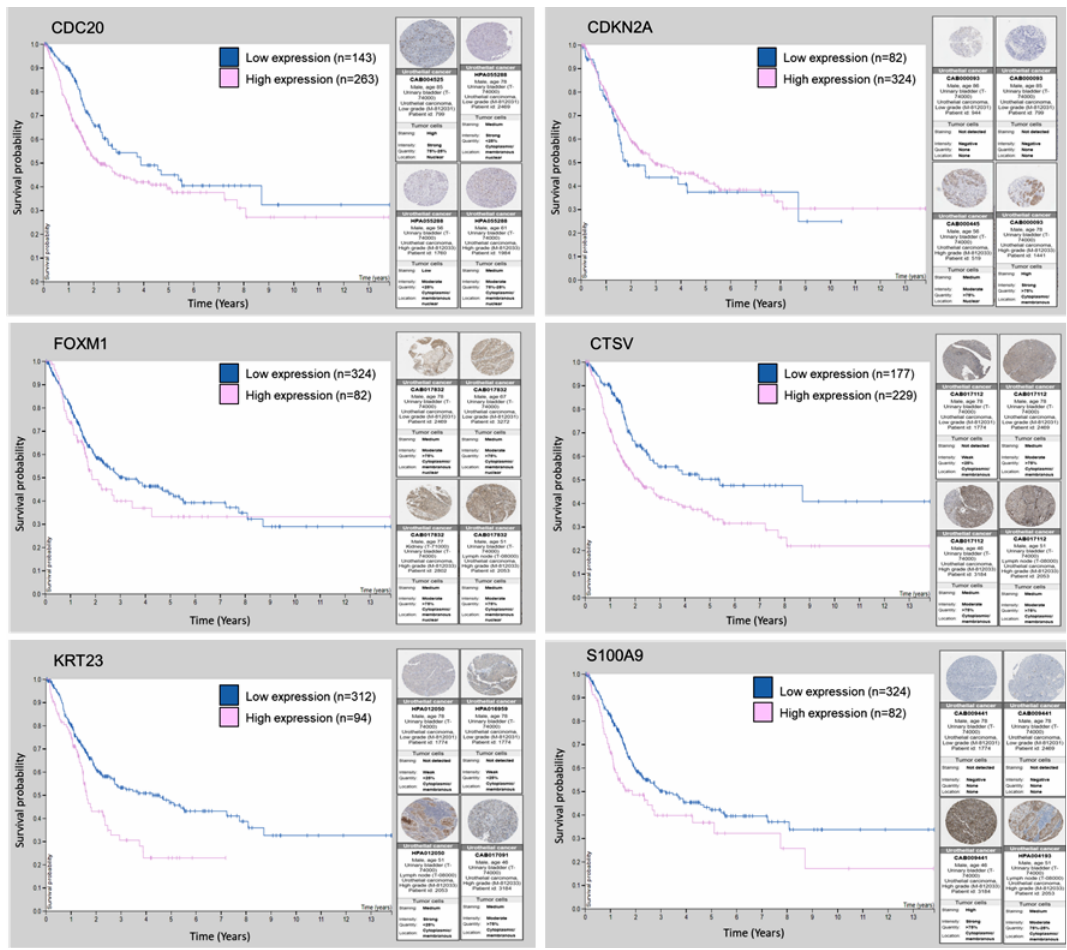
Figure 8. Kaplan–Meier survival plots of CDC20, CDKN2A, CTSV, FOXM1, KRT23, and S100A9 and their protein expression stratified into low-risk and high-risk groups from the TCGA and human protein atlas database. Table 3. Patient characteristics.